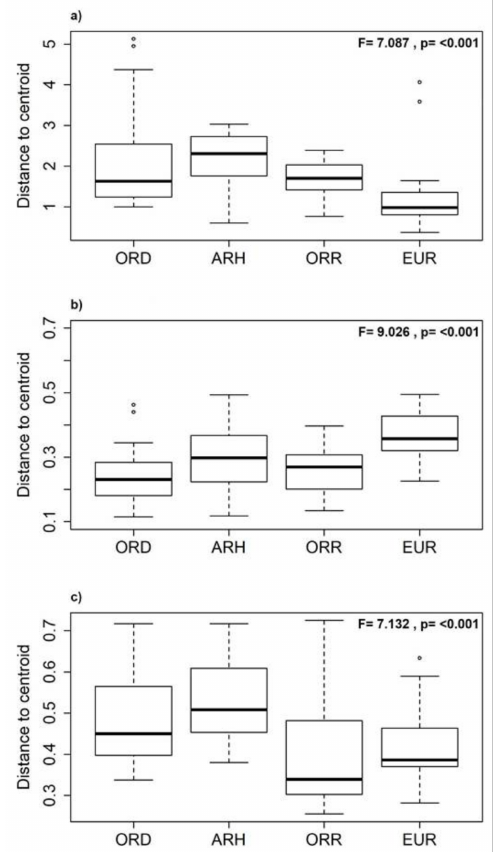
Figure 5. Boxplots of the test of homogeneity (PERMDISP) representing the mean distance from groups centroids and the outliers values ( ◦ ) of the environmental heterogeneity with Euclidean dis- tance ( a ); taxonomical structure using abundance and Bray-Curtis dissimilarity ( b ), and taxonomical community using presence/absence and Sørensen dissimilarity ( c ) of the aquatic states (see acronyms of aquatic states in Figure